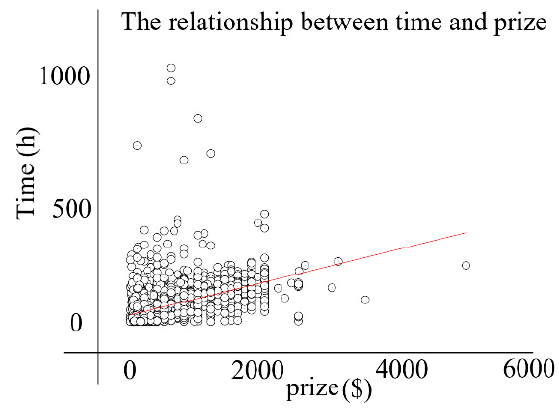
Figure 6. The relationship between time and prize.